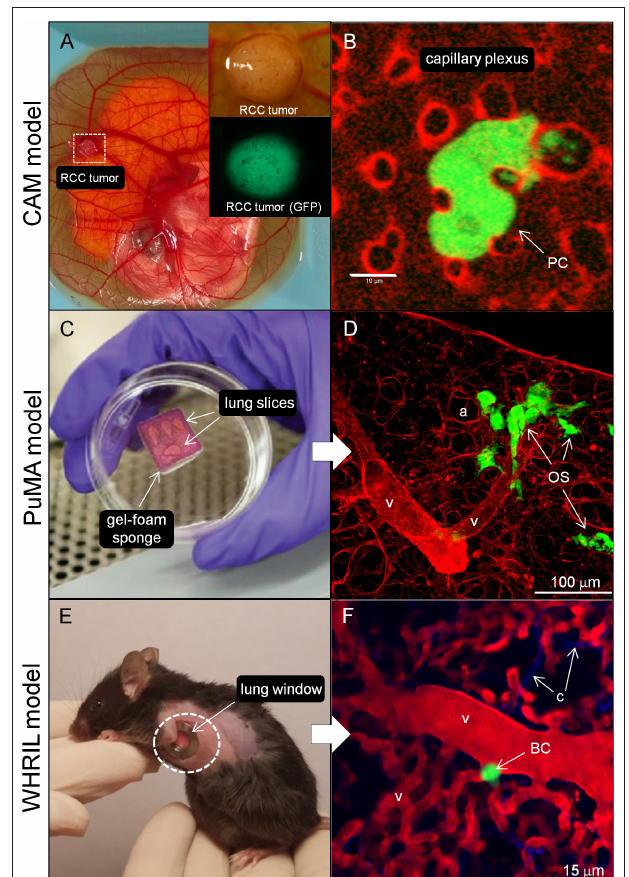
FIGURE 2 | Imaging models to study the metastatic cascade in cancer. (A) The CAM model (whole mount image) showing the chick embryo and highly vascularized CAM. A small renal cell carcinoma (RCC) explant can be seen growing in the dashed white box. Zoomed image of a different established GFP-expressing RCC tumor where the entire tumor, associated vasculature, and corresponding fluorescence image (below) are shown (Image courtesy of Matthew Lowerison and Pengfei Song, UIUC). (B) High magnification, single cell imaging of a GFP-labeled prostatic carcinoma cell (PC) migrating through capillary plexus (labeled with rhodamine-lectin) and forming invadopodia (yellow arrowheads) into the lumen of 2 adjacent capillaries in the CAM model (Image courtesy of Fabrice Lucien and Yohan Kim, Mayo Clinic). (C) The PuMA is an ex vivo lung explant model where tumor cells in viable lung tissue is maintained in cell culture. The lung slices are kept at an air-liquid interface on top of a gelatin sponge. (D) Shows the lung parenchyma (stained red with DAR4M) and eGFP-expressing MG63 OS cells (OS) interacting with vessel-like structures (v). Scalebar = 100 µ m. See Lizardo and Sorensen (88) for methods. (E) The WHRIL model allows for the direct visualize of lung tissue through a window in the mouse chest cavity (89) as shown with the dashed white circle. (F) Fluorescent micrograph showing the lung microvasculature (v) (labeled red with tetramethylrhodamine) and GFP-expressing breast cancer cell (BC). Blue fibers represent second harmonic imaging of connective tissue (c) fibers. Scalebar = 15 µ m (Images courtesy of David R. Entenberg, Albert Einstein College of Medicine). UIUC, University of Illinois at